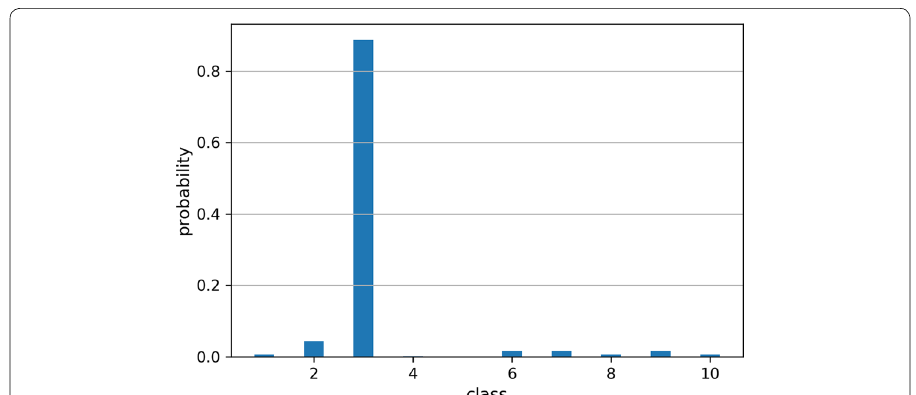
Fig. 2 A probability distribution based on the softmax activation